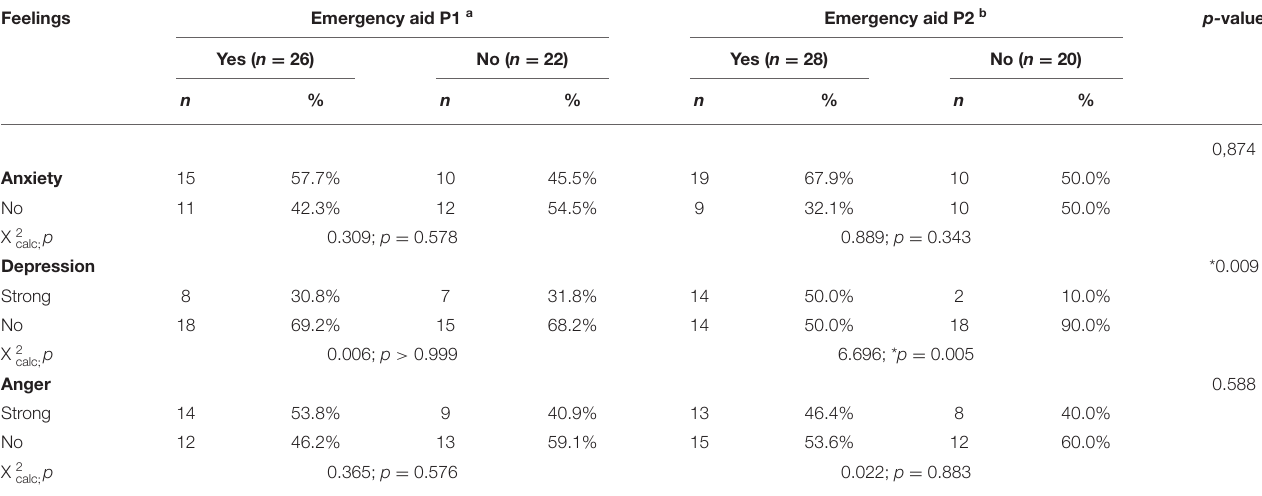
TABLE 4 | Absolute and relative distribution for “emergency assistance” in the initial (P1) and final (P2) segments according to anxious, depressed, and angry feelings.